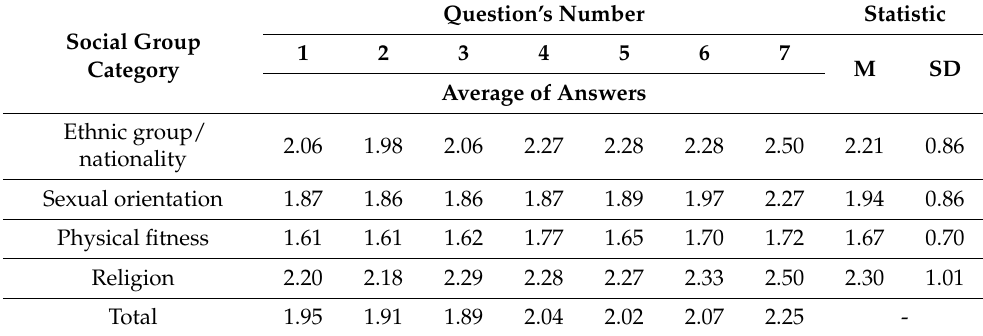
Table 3. The mean of the respondents’ answers to particular questions in relation to social group.